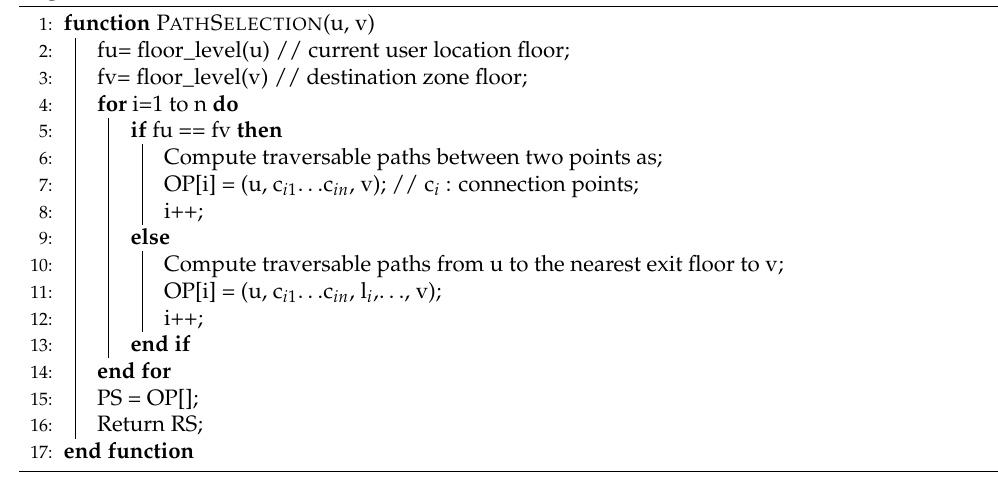
Algorithm 2 Semantic indoor Path Selection